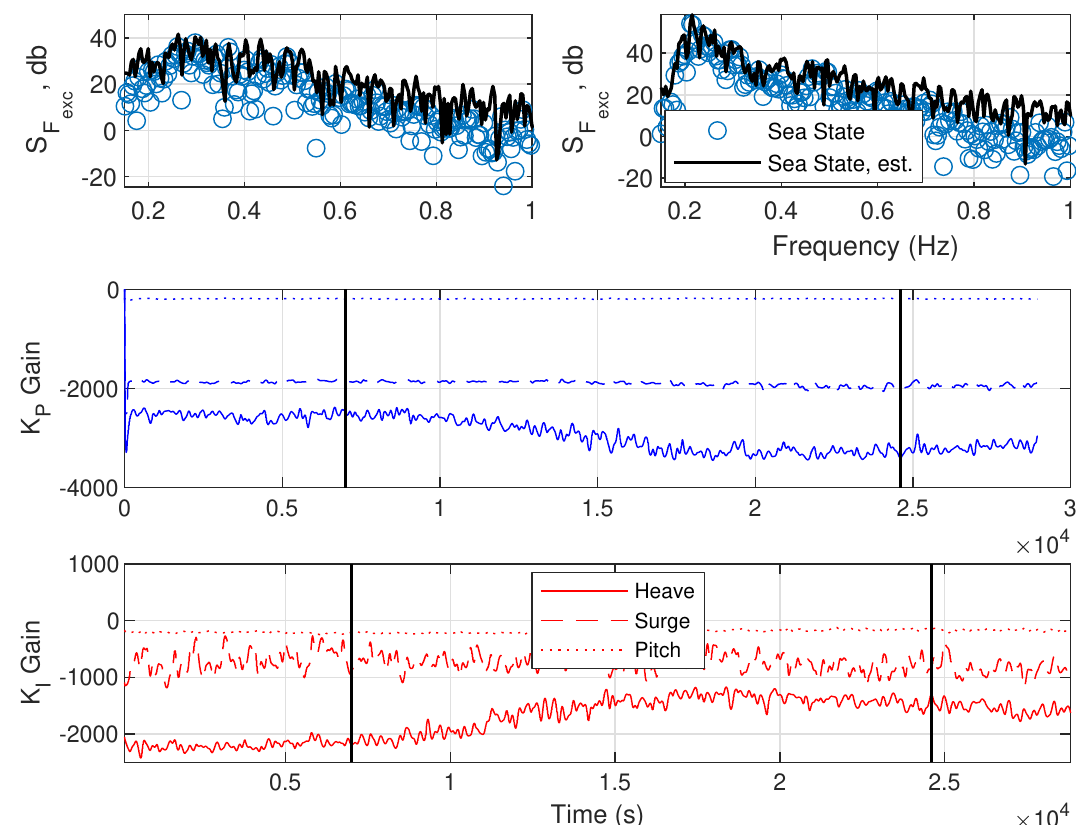
Fig. 6: Self-tuning controller gains for the CDIP225 wave state. Heave, surge, and pitch line styles are consistent across the lower two subplots.